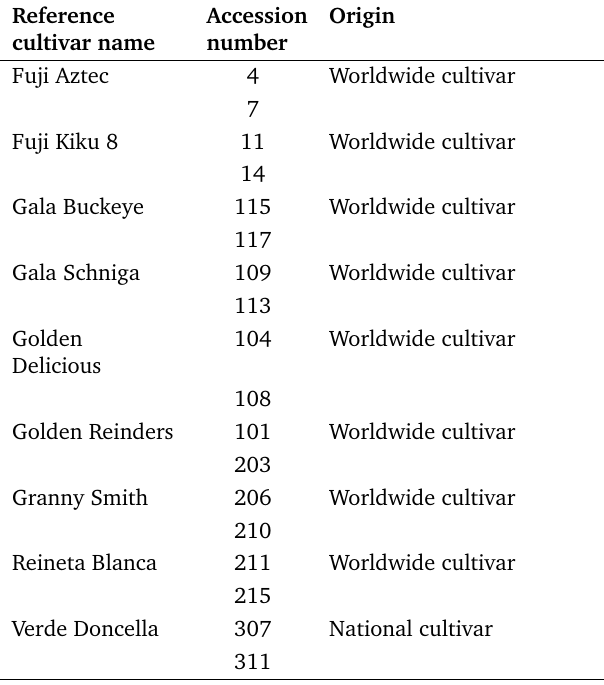
Table 2. Reference cultivars curated in the IMIDRA